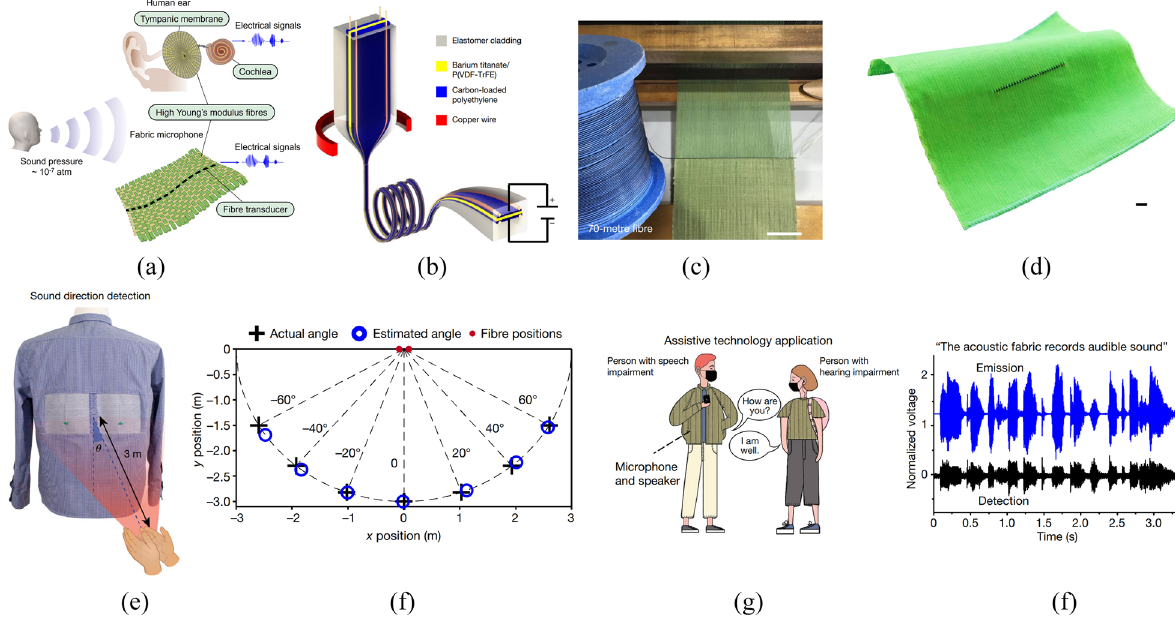
Fig. 7 Application of TDPFs for communications. a Tympanic membrane structure and development of the fiber-on-membrane model. b Struc- ture of a rectangular TDPF used for communication. c TDPFs incorporated into the fabric via weaving process. d Photograph of the Twaron- weft acoustic fiber containing one fiber transducer. e Photograph of TDPF woven acoustic fabric integrated shirts. f Sound direction detection performance of TDPF-based wearable electronics. g TDPF based acoustic fabrics could act as an assistive communication technology. h Demon- stration of acoustic communication using two shirts. Reprinted with permission from Ref.